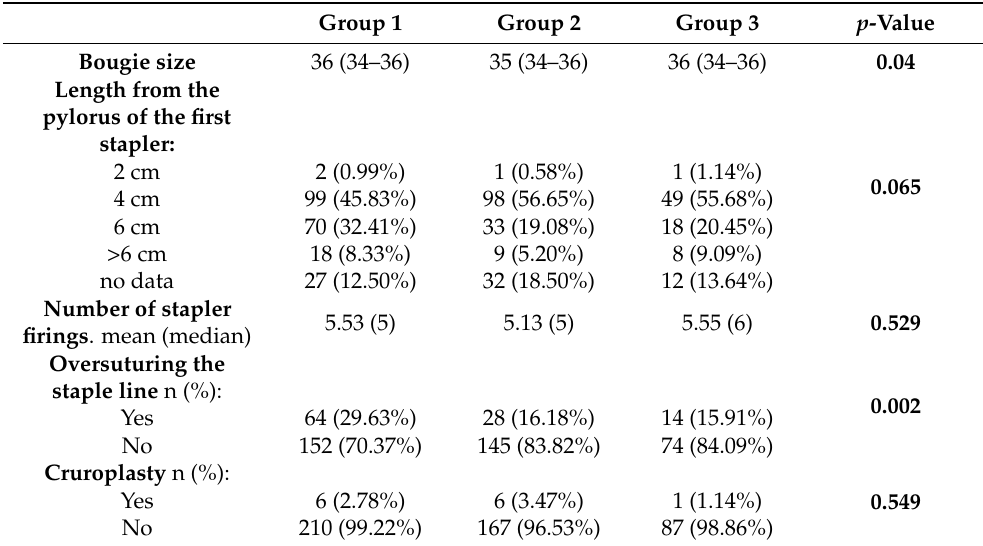
Table 2. The differences in the elements of the surgical technique during the primary sleeve gastrec- tomy. Group 1 Group 2 Group 3 p -Value Bougie size Length from the pylorus of the first stapler: 2 cm